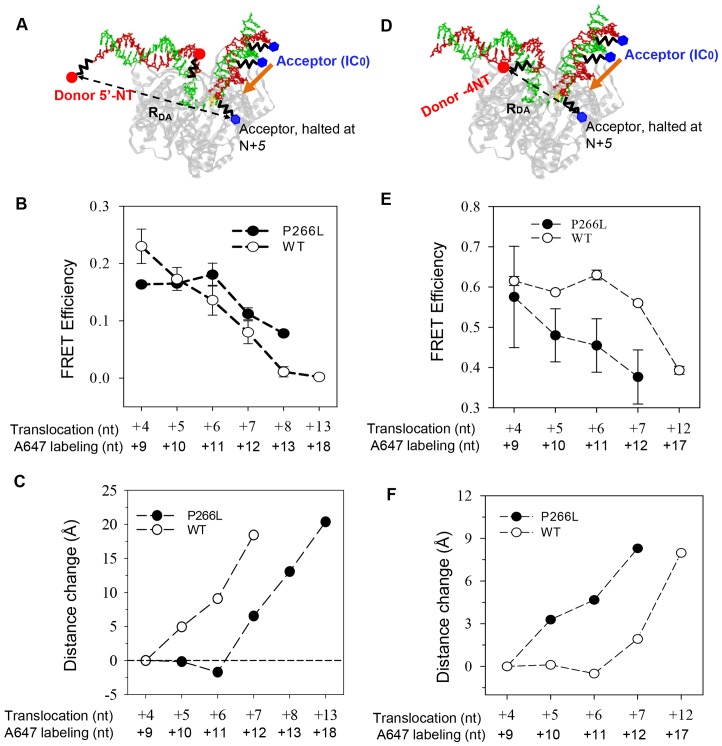
The P266L mutation modifies both rotation and DNA scrunching changes during initiation.(A) Cartoon illustration of FRET experiments to measure promoter rotation. The polymerase is in gray, the non-template strand in red and the template in green. Fluorescent donor TAMRA (red sphere) was introduced at position −22 in the non-template strand and acceptor Alexa 647 (blue square) at designated downstream positions on the template strand. Transcription complexes were walked to position N (+4 to +13) and FRET efficiency between donor (D) at −22 and acceptor (A) at N+5 was measured to obtain the D-A distances (RDA, discontinuous line). (B and C) Average FRET efficiency and changes in D-A spatial distances are shown for P266L and WT T7 RNAP (D) Cartoon illustration of FRET experiments to measure DNA scrunching. The donor Cy3 (red sphere) was labeled on position −4 and acceptor Cy5 (blue square) labeled on downstream N+5 positions as above. (E and F) Average FRET efficiency and changes in averaged D-A spatial distances between Cy3 at the upstream edge (−4) and Cy5 at the downstream N+5 positions with the P266L and WT T7 RNAP complexes. The error bars of FRET efficiency represent the standard deviations from multiple independent measurements (N≥3).